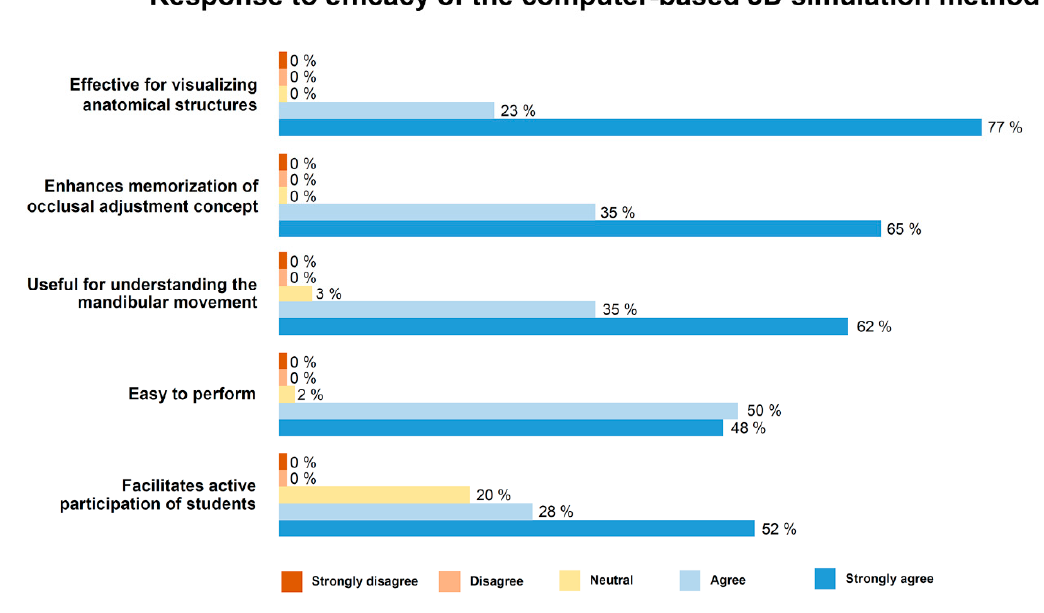
Figure 4. Attitudinal survey results on the efficacy of the computer-based 3D simulation method.